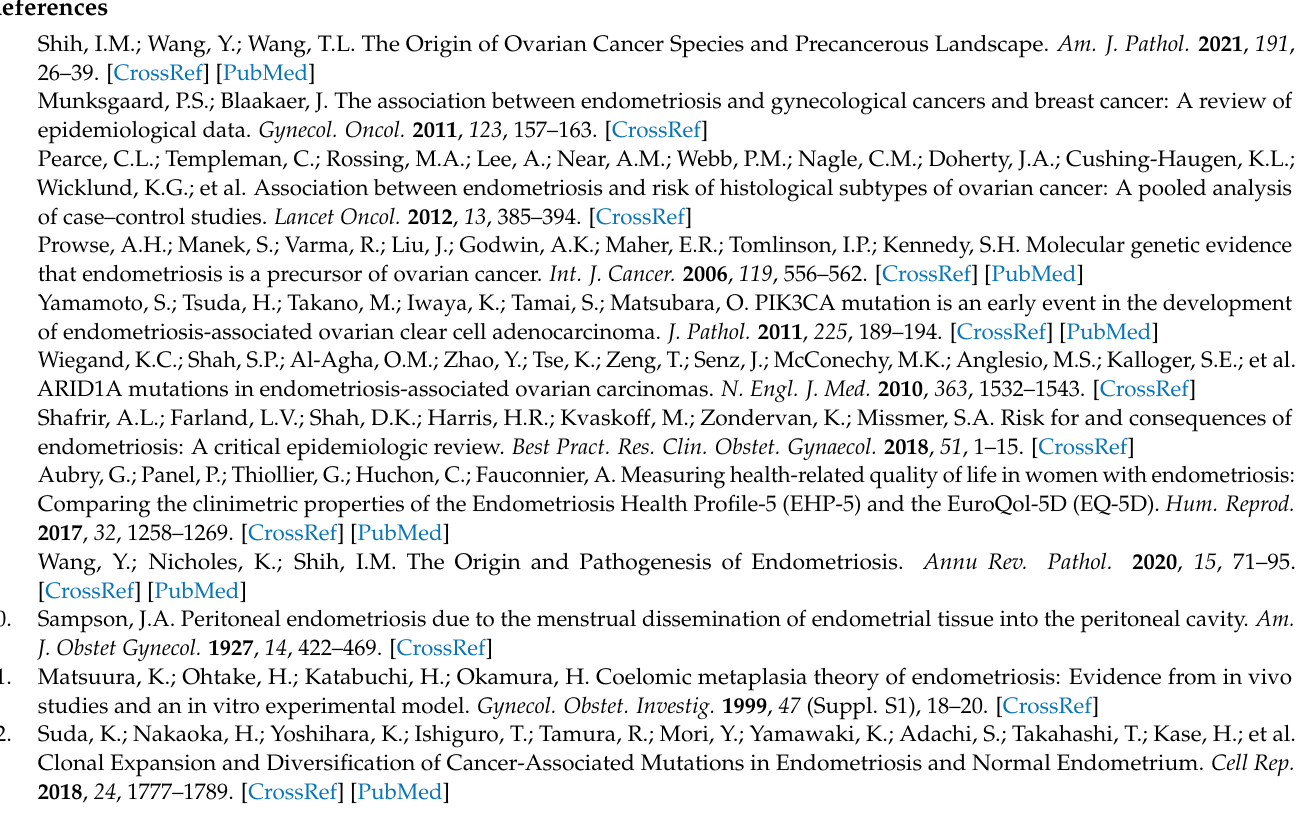
Figure 2A. Uterine endometrium and endometriosis with and without ARID1A first hit retain ARID1A expression, while ovarian cancer with ARID1A second hit demonstrates loss of ARID1A expression. Figure 2B. The image shows molecular mechanism of EAOC development from uterine endometrium via endometriosis. At first, endometrial epithelial cells with cancer-associated gene mutation in uterine endometrium transfer to ovary through a retrograde menstruation and demonstrate clonal expansion in endometriosis. Next, ARID1A heterozygous mutation occurs in the process of endometriosis development and second hit of ARID1A such as genomic or epigenetic alteration leads to malignant transformation of endometriosis. The illustrations were created with reference to Tomasetti et al.